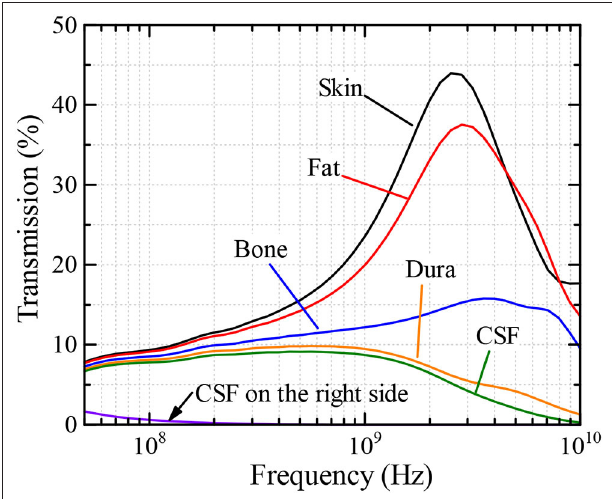
FIGURE 4 | Transmission characteristics at observation points inside biological tissue layers.